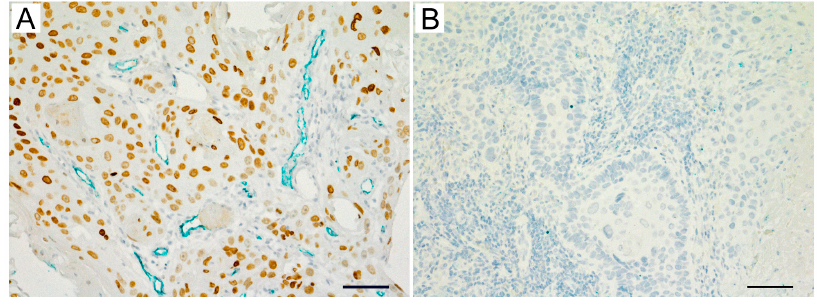
Figure 6. Blood vessels are increased in oral squamous cell carcinoma (OSCC) tissues with high HMGA2 expression. The association between blood vessel status, based on C34 staining and HMGA2 expression, as measured by immunohistochemical double staining with OSCC tissues. ( A ) HMGA2-high expression, ( B ) HMGA2-negative expression. CD34: green, HMGA2: brown. Scale bar, 100 µ m.